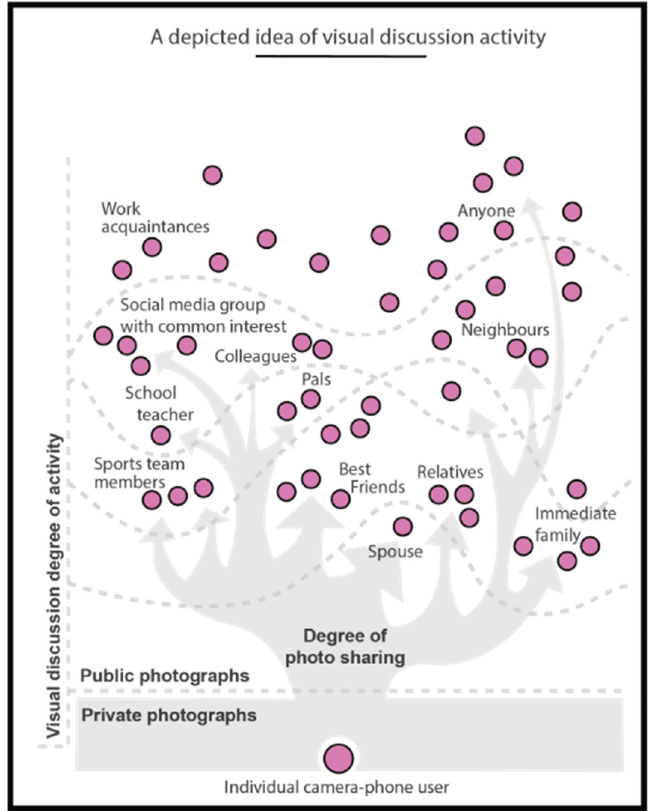
Figure 1. Outside the tasks defined by working life, the degree of visual discussions is most active among close friends and relatives (Näsi 2020, p. 12).